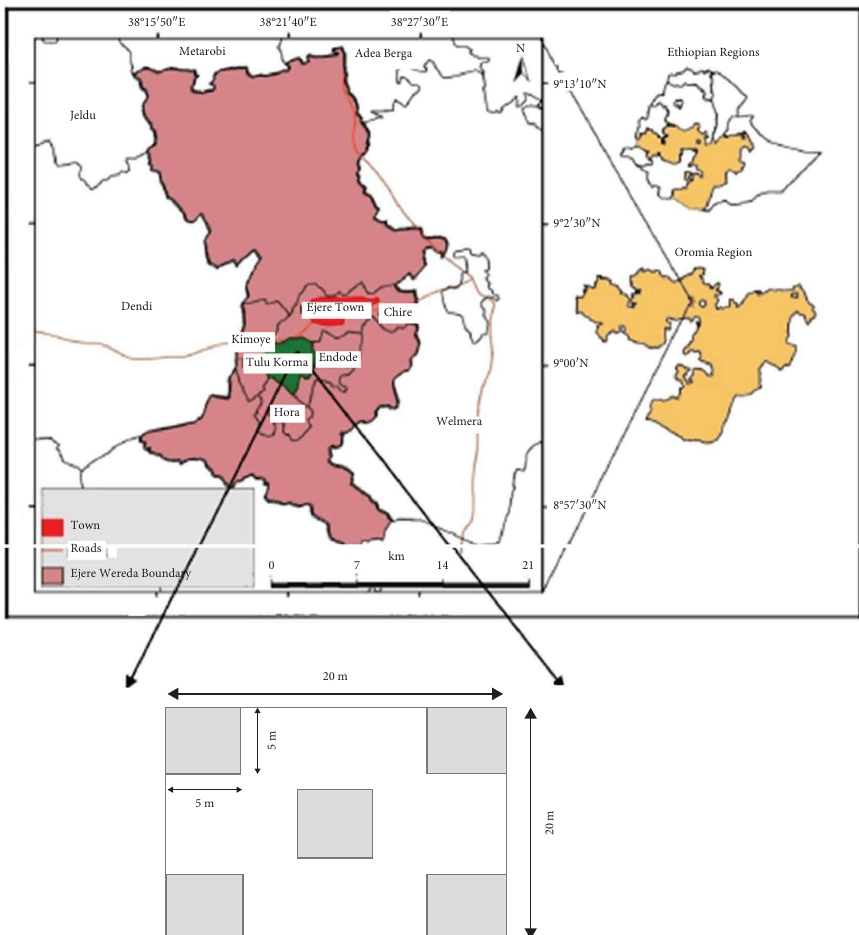
Figure 1: Location map of Tulu Korma Forest and Ejere areas with sampling plot design.